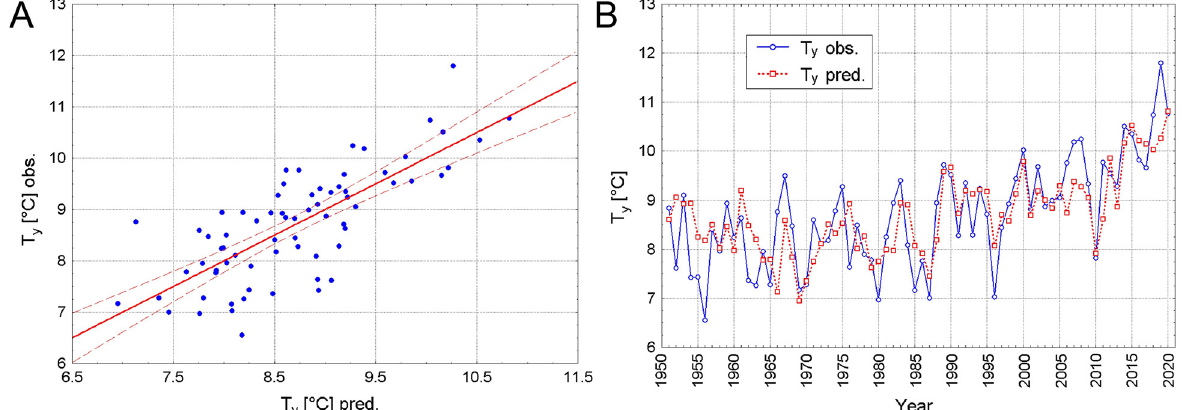
Fig. 11. Values of the annual temperature (T (T obs.) (A) and their course (T y